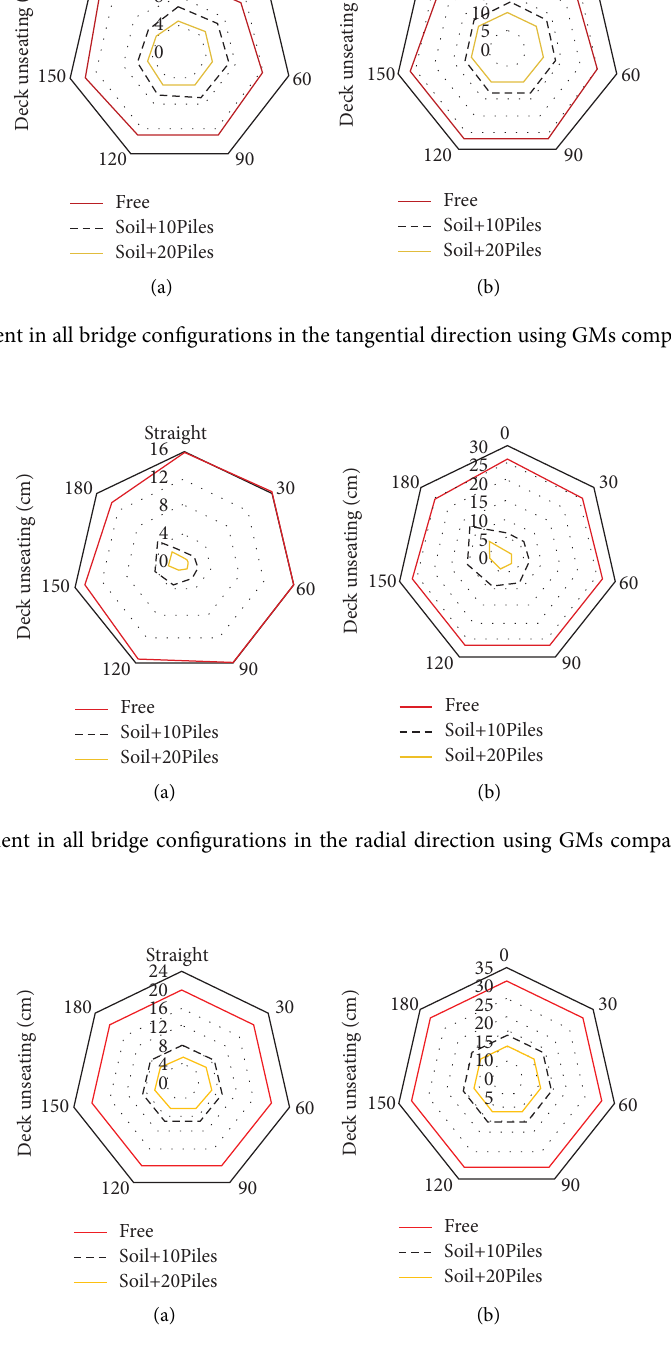
Figure 23: Real abutment displacement in all bridge confgurations using GMs compatible to (a) DBE and (b) MCE response spectrums.